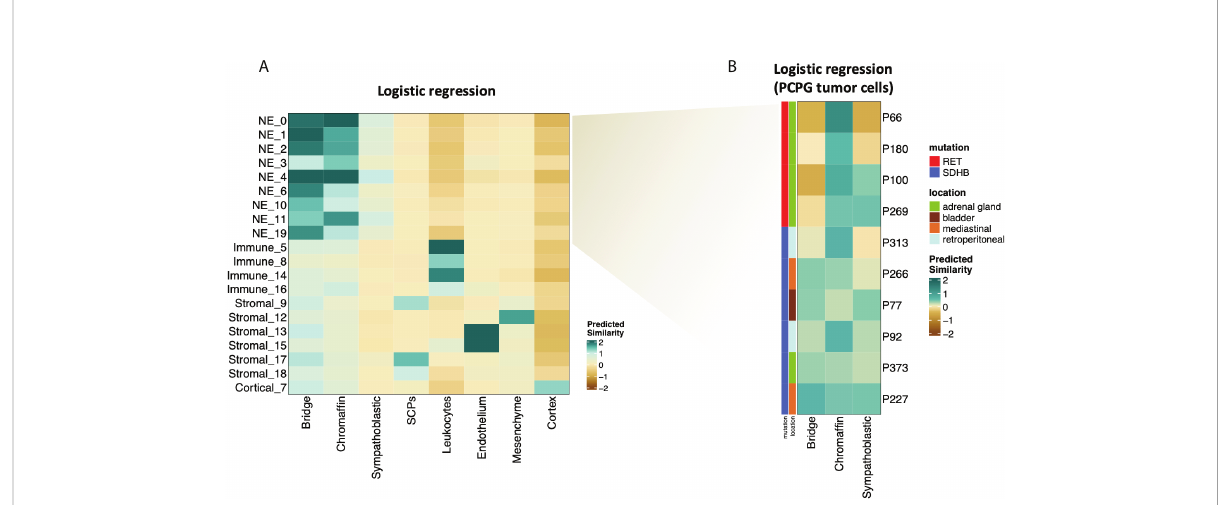
FIGURE 5 (A) Heatmap showing similarity scores (logistic regression and logit scale) of the signatures of developing cell types from (17) (fetal adrenal dataset) (x axis) to PCPG cells (y axis). (B) Heatmap showing similarity scores (logistic regression and logit scale) of the signatures of developing adrenal cell types from (17) (fetal adrenal dataset) (x-axis) to PCPG tumor cells by patient